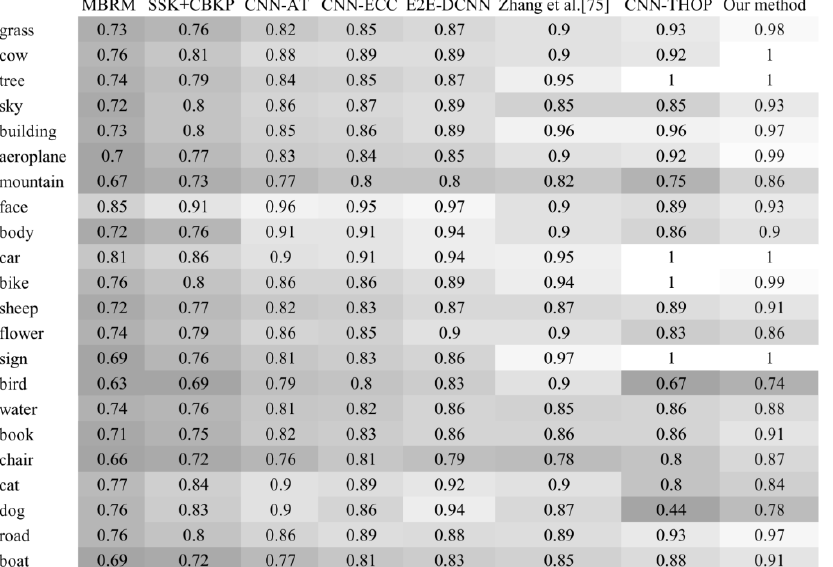
Figure 9. Precision heatmap generated from the precision per concept produced by each method. Lower precisions are indicated by darker cells. The methods involved in this experiment are MBRM [27], SSK-CBKP [89], CNN-AT [54], CNN-ECC [90], E2E-DCNN (2019) [66], CNN-THOP [74], Zhang et al. [76], and our method.